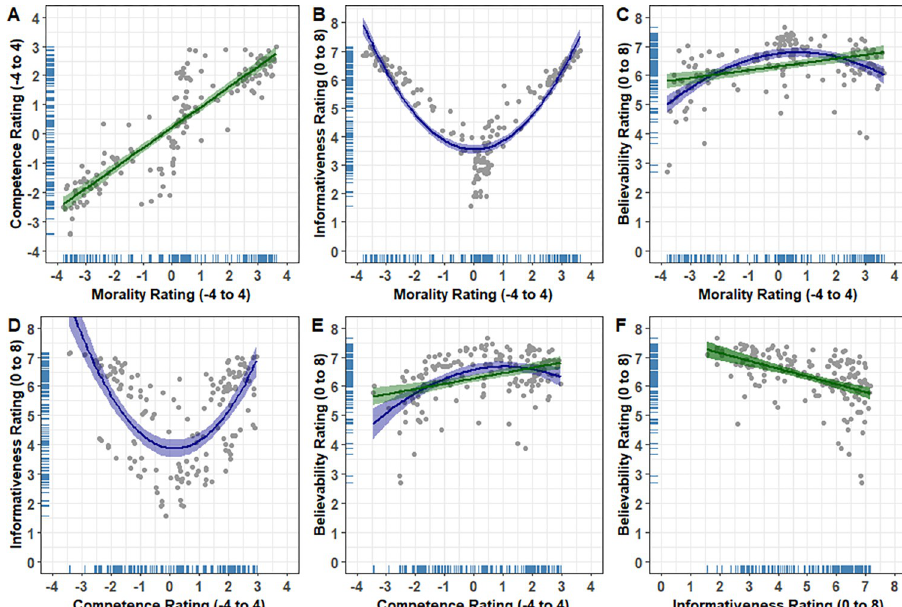
Fig 3. Scatter plots depicting the association between (A) morality and competence, (B) morality and informativeness, (C) morality and believability, (D) competence and informativeness, (E) competence and believability, and (F) informativeness and believability. Dot points represent the mean ratings for each behavior statement. The green lines show the linear trends and the blue lines show the quadratic trends. The shaded areas show the 95% confidence intervals. Rugs (i.e., the blue lines along the x - and y -axes) show distribution density.